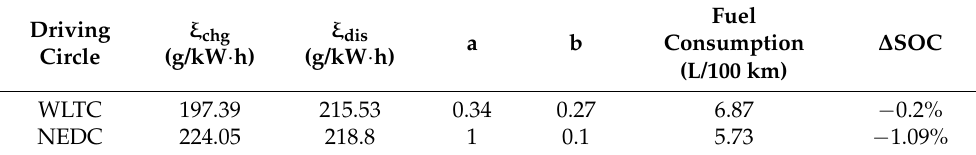
Table 7. The parameters after the ECMS